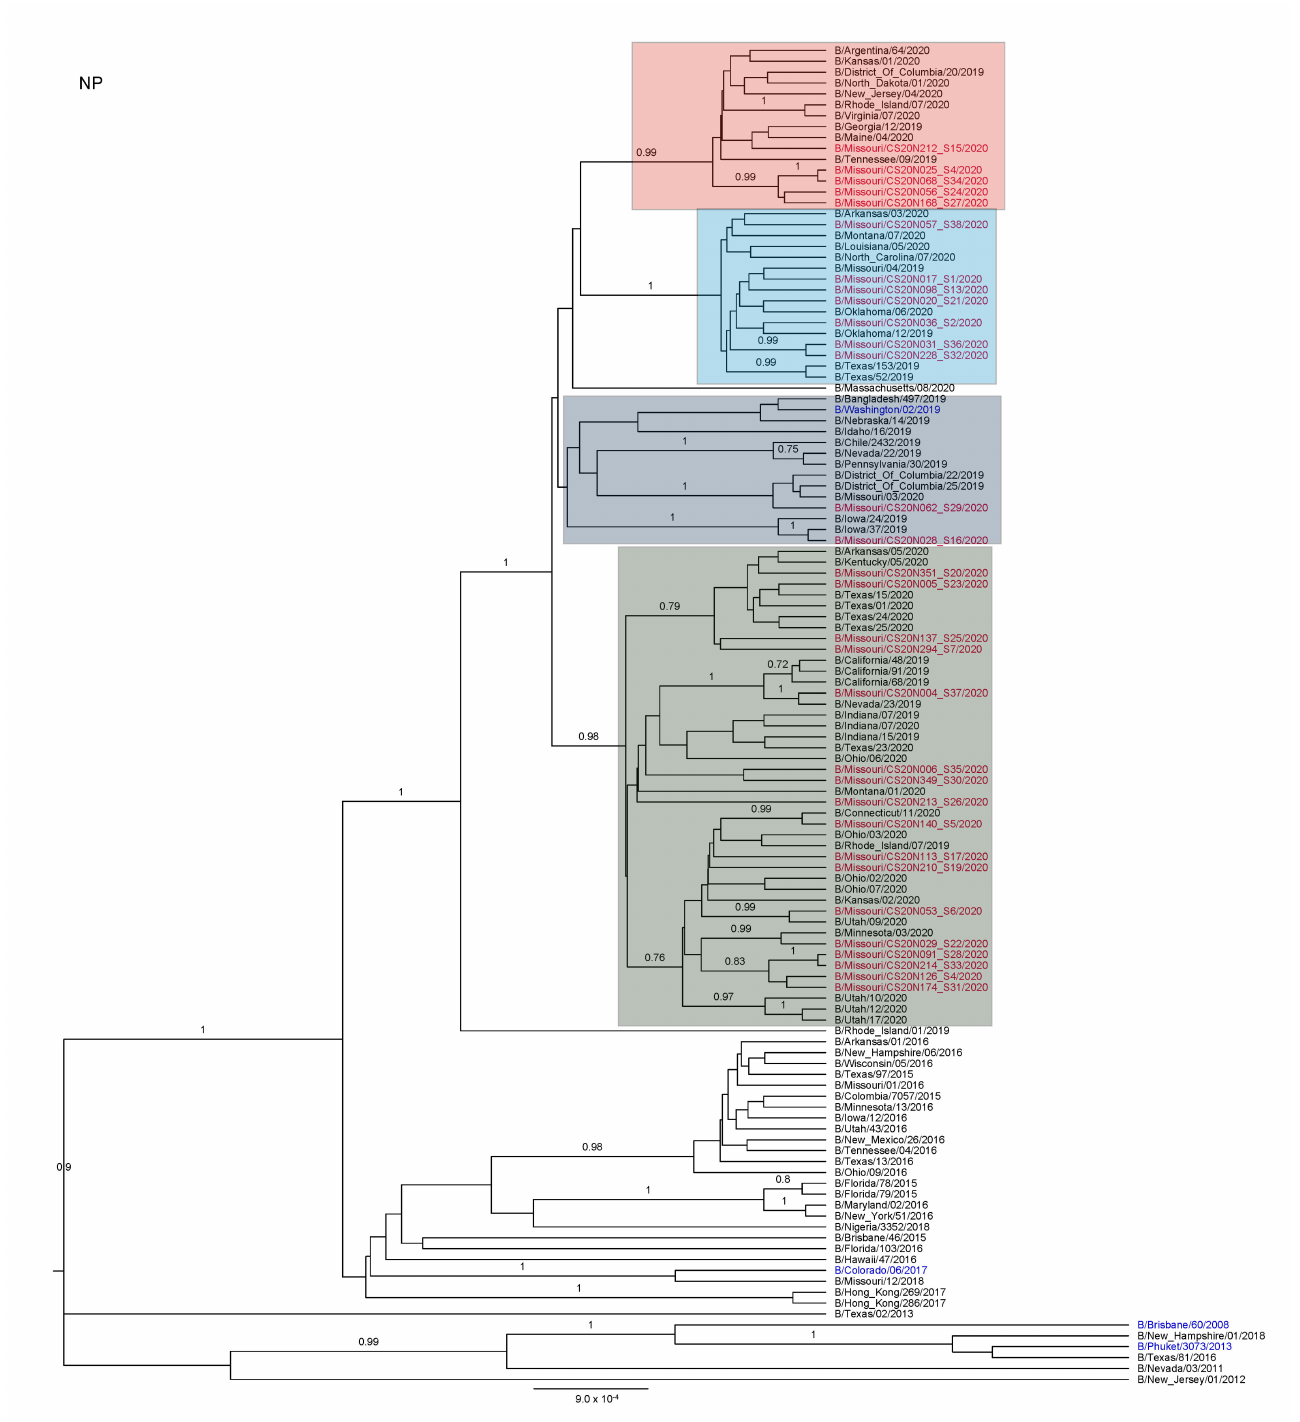
Figure A5. NP Tree. The phylogenetic analyses were performed by using BEAST2 with a Hasegawa–Kishino–Yano (HKY) substitution empirical model, strict clock model, and coalescent constant population prior. Branches with a posterior probability >0.70 were